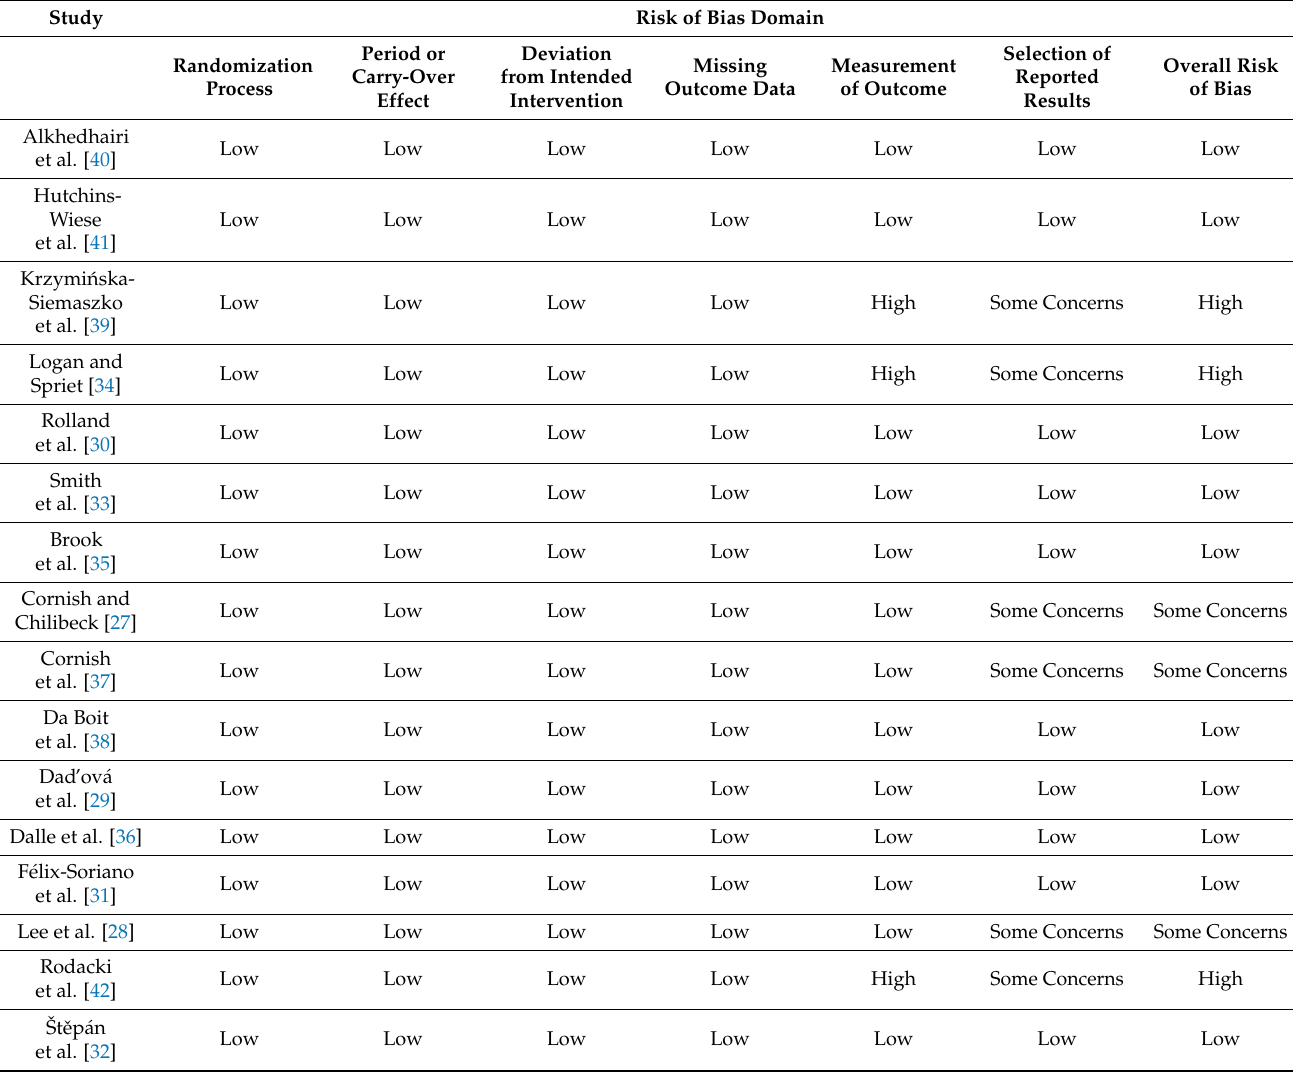
Table 2. Risk of bias assessment for included